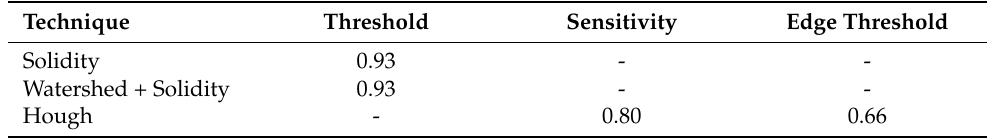
Table 1. Parameters of each image processing